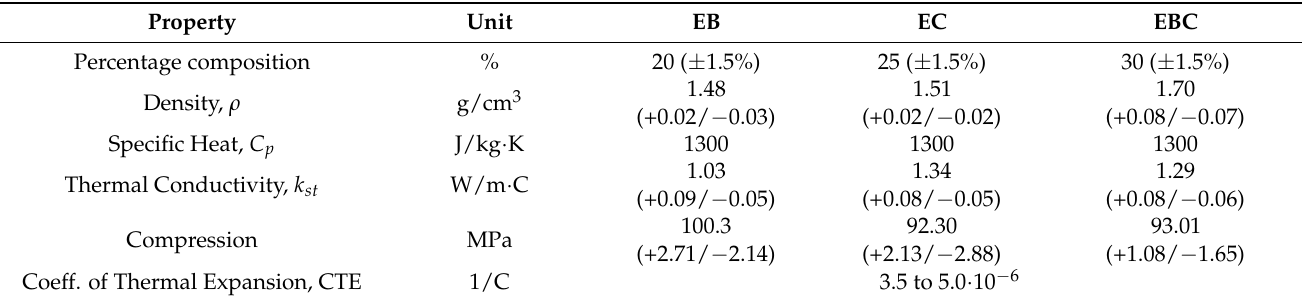
Table 3. Properties of mold insert material at high compression